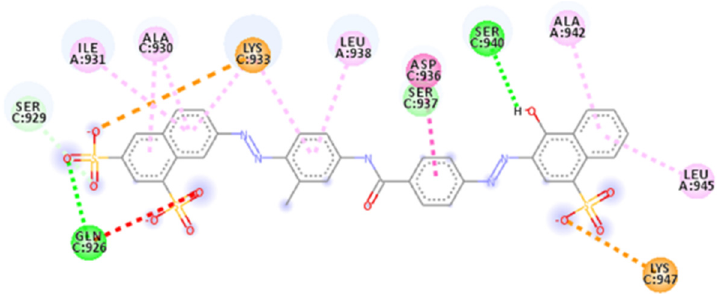
Figure 7. Calculated 2D interactions of ZINC000150368097 in complex with SARS-CoV-2’s HR1 do- main.